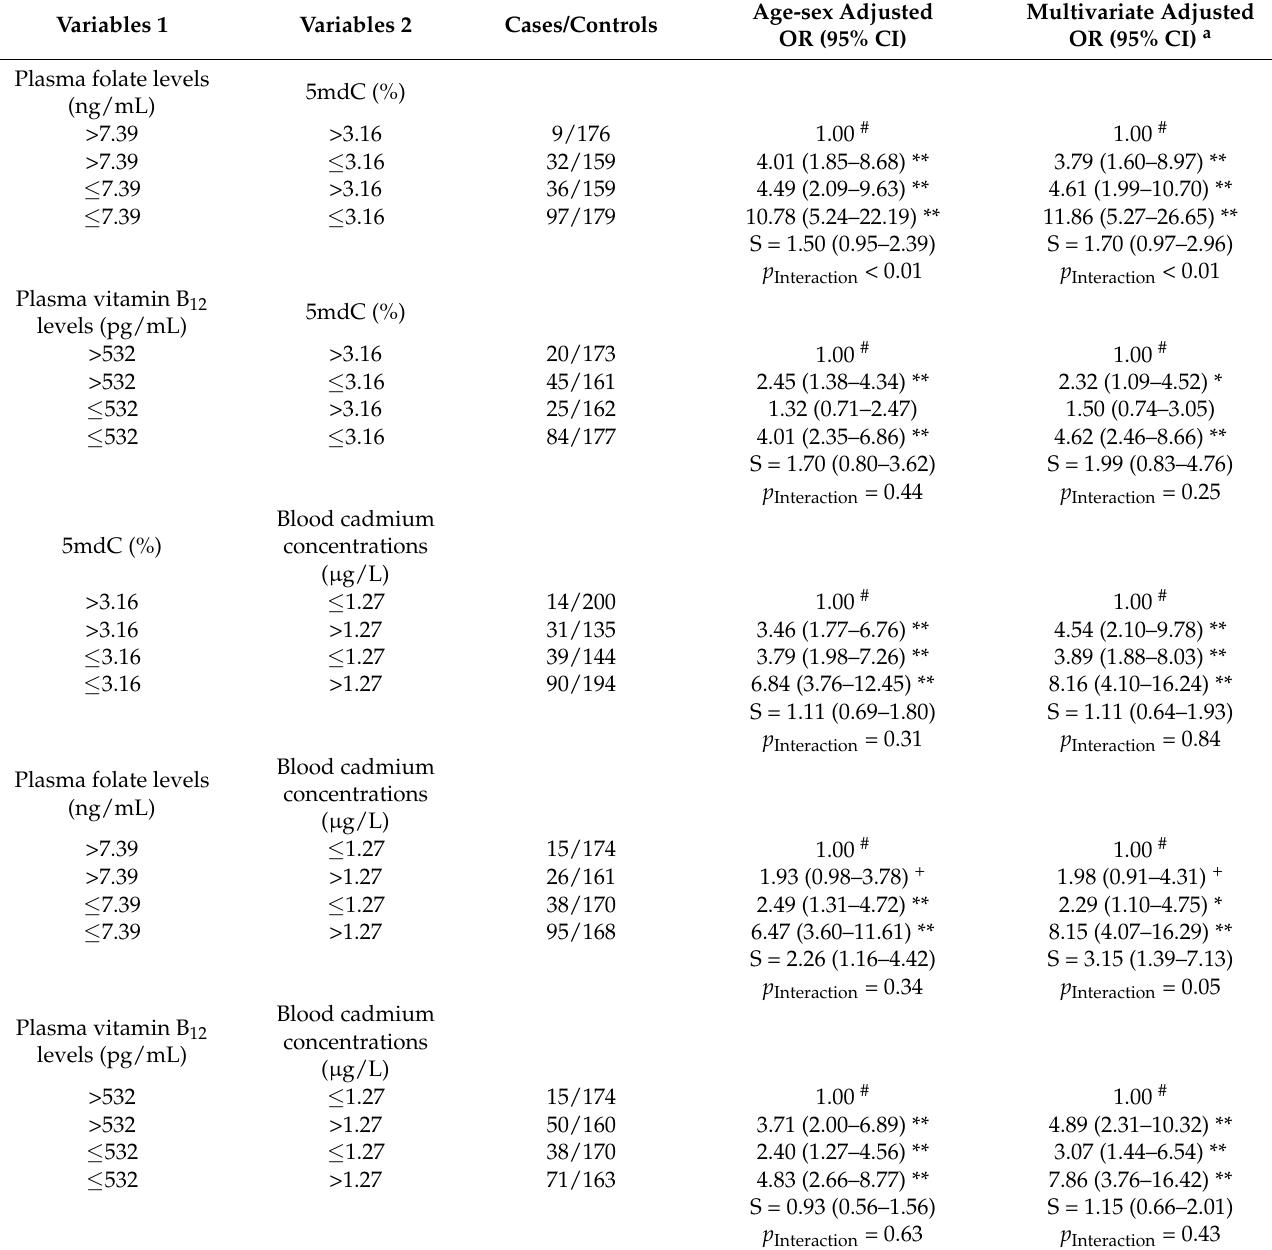
Table 3. Combined effects of 5mdc (%), plasma folate and vitamin B 12 , and blood cadmium levels on